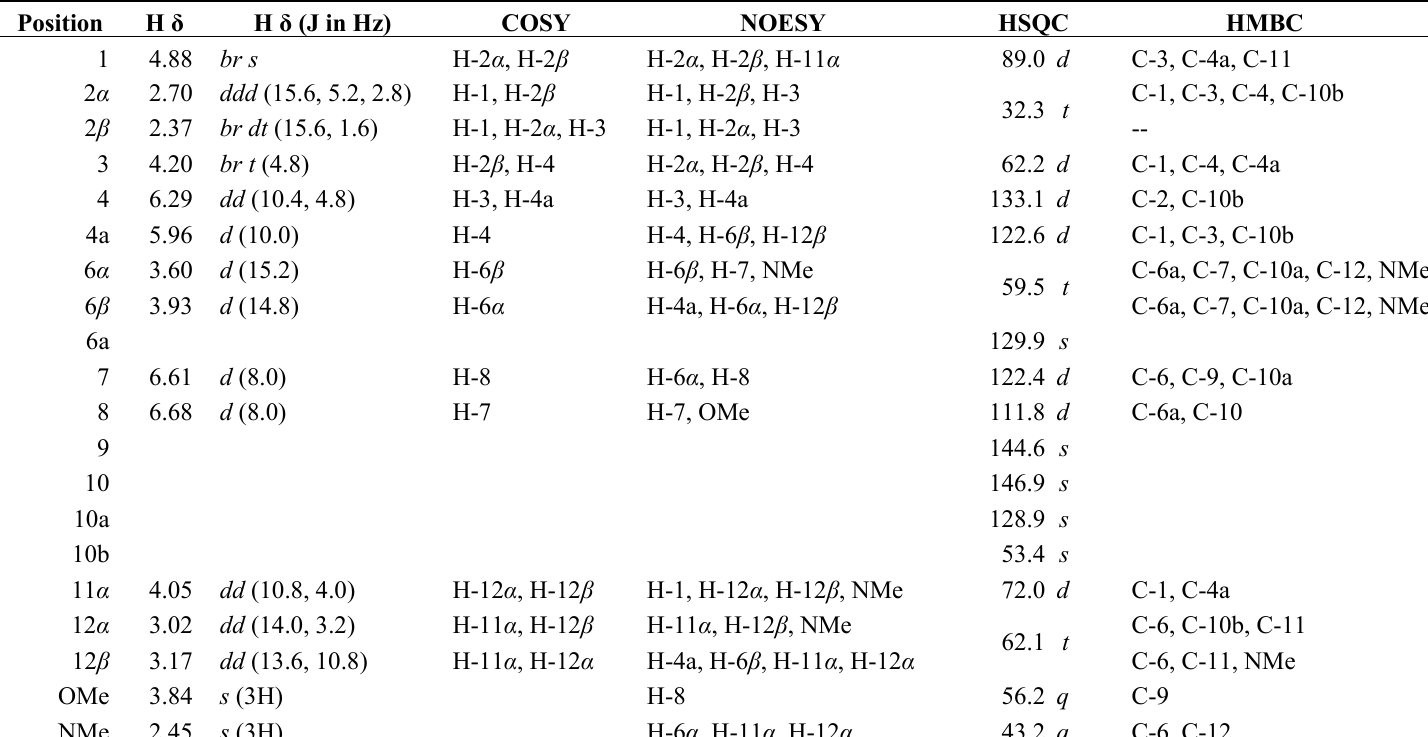
Table 1. 1 H NMR, COSY, NOESY, HSQC and HMBC data of 11 β -hydroxygalanthamine (400 MHz, CDCl